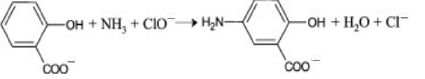
Figure 1. Reaction principle of salicylate method.